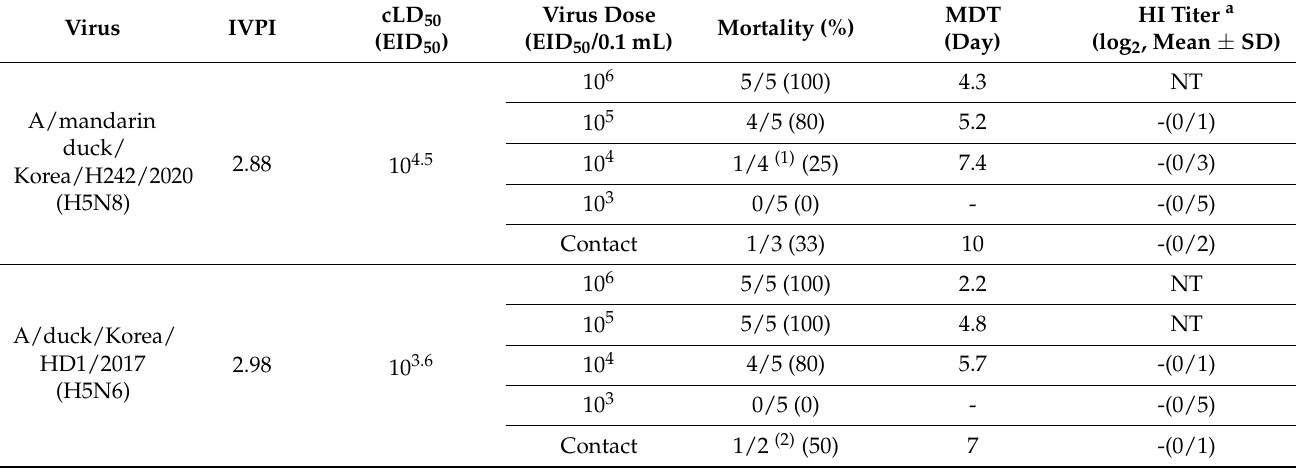
Table 1. Pathogenicity and transmissibility of H242/20(H5N8) and HD1/17(H5N6) in SPF chickens.